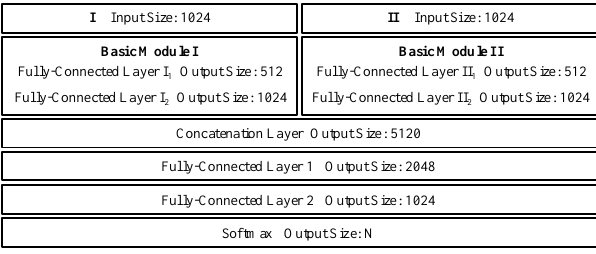
Figure 7. The detailed construction of the two-stream deep feature fusion model.